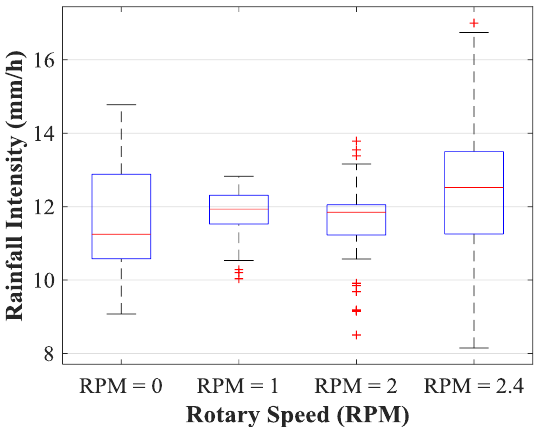
Figure 8. Boxplots of rainfall intensities at different rotary speeds.